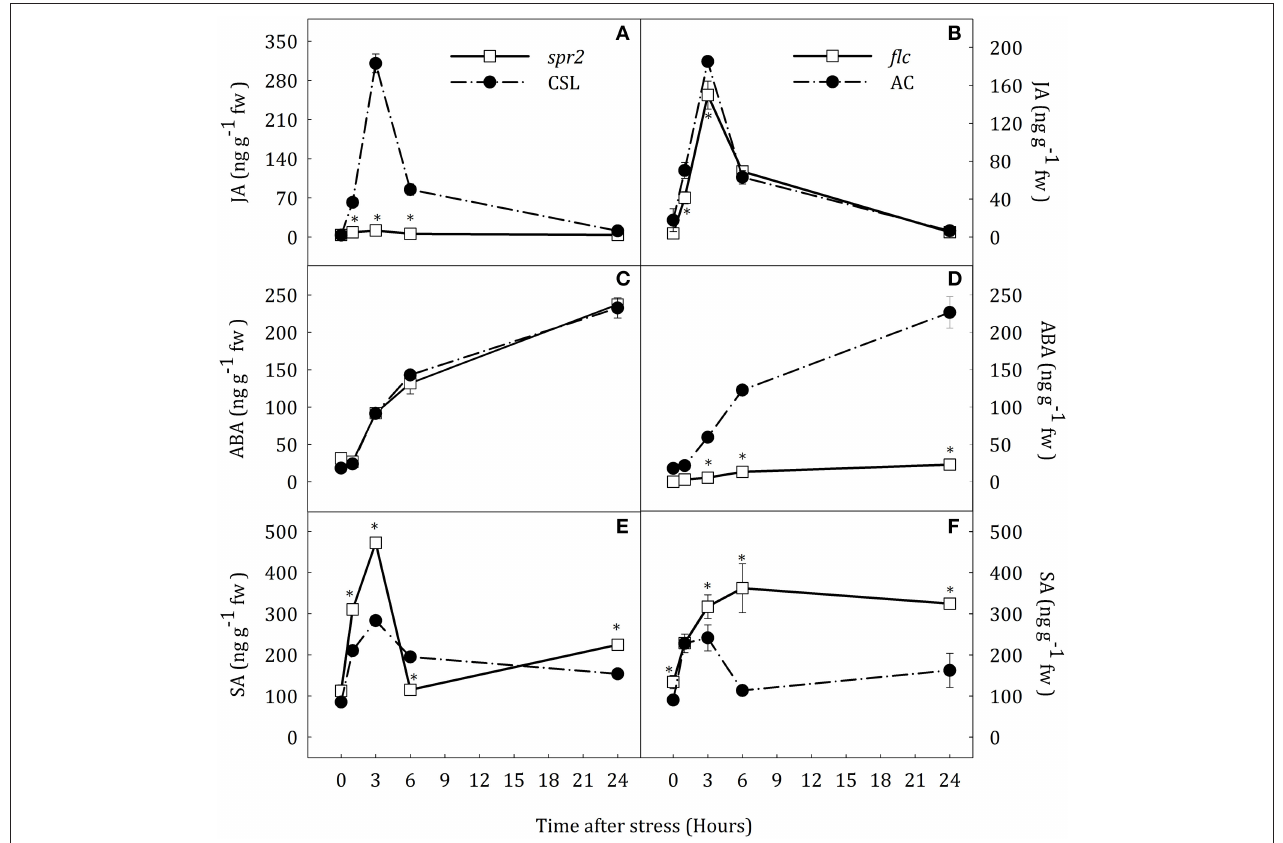
FIGURE 1 | JA (A,B), ABA (C,D) and SA (E,F) levels in roots of Solanum lycopersicum [WT (CSL and AC, black circles) and mutants ( spr2 and flc , white square)] under control ( t = 0 ) and water-stress conditions. Data are mean values ± standard deviation of three independent determinations. Asterisks denote statistical difference with respect to WT at p ≤ 0.05